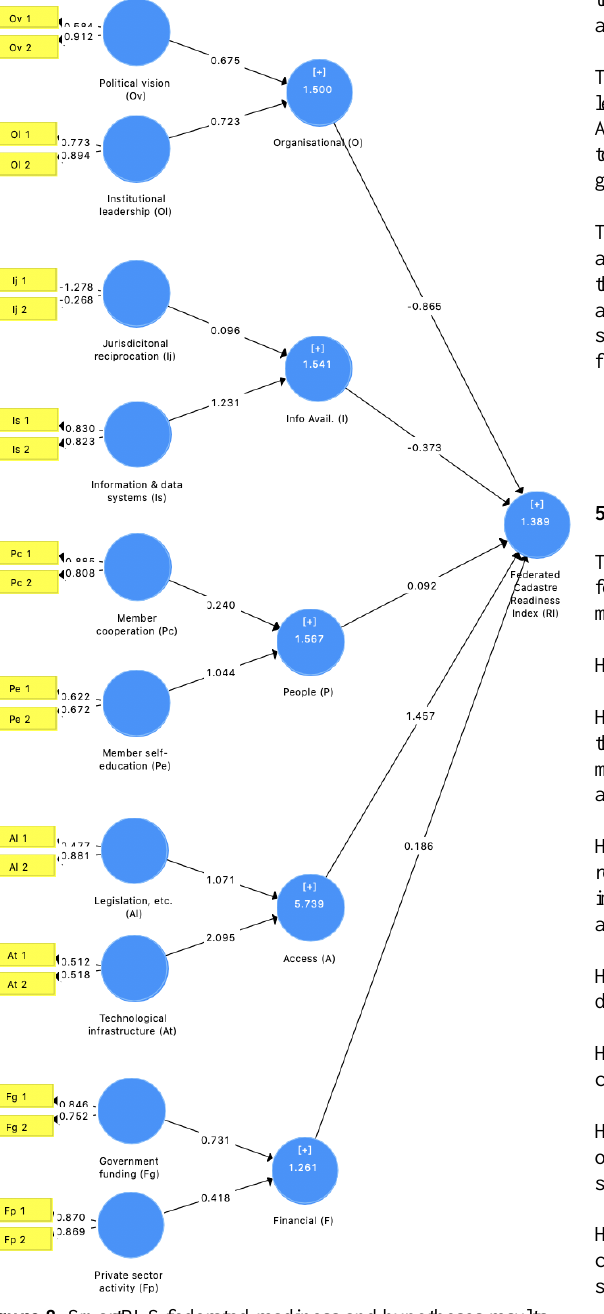
Figure 8 . SmartPLS federated readiness and hypotheses